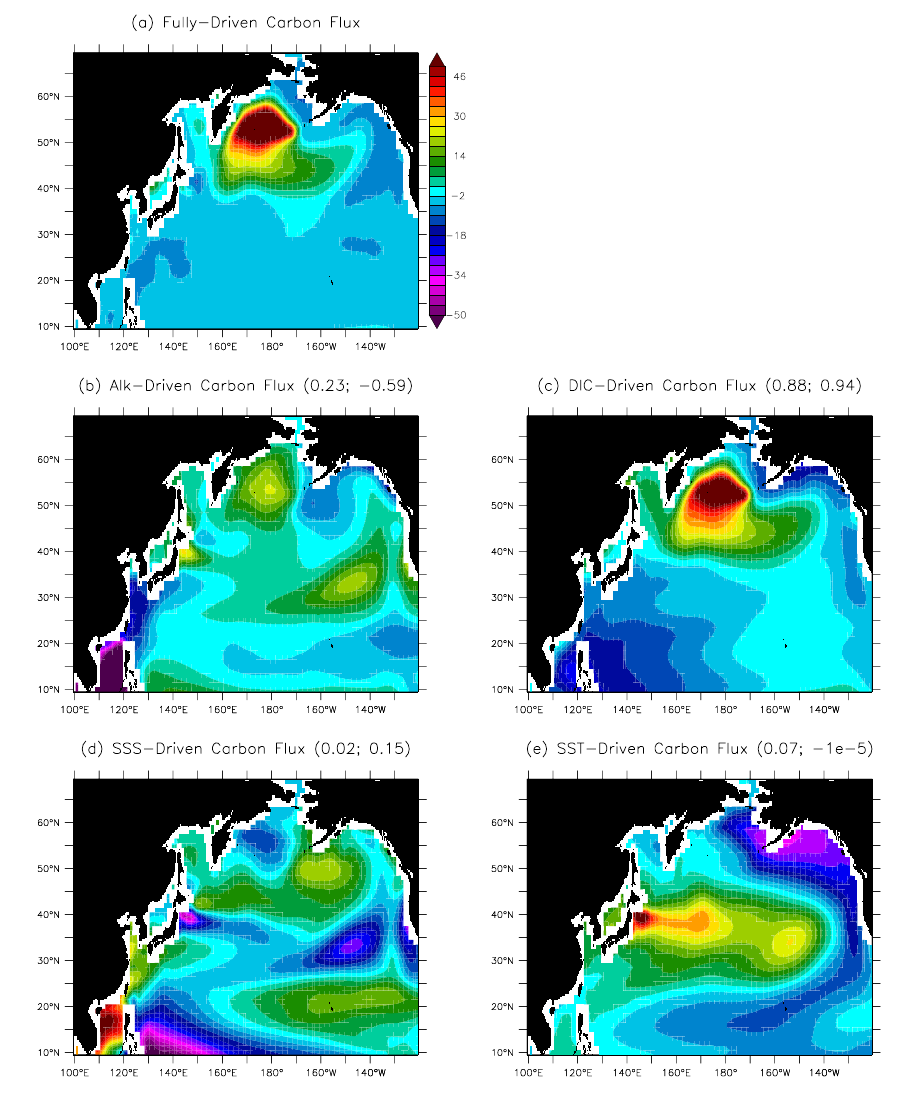
Fig. 6. Spatial pattern of the leading empirical orthogonal function (EOF, in normalised unit) of (a) the fully-driven carbon fluxes, and that of the Alk-driven (b) , DIC-driven (c) , SSS-driven (d) and SST-driven (e) ocean carbon fluxes in the North Pacific. Spatial correlations (based on EOFs) and temporal correlations (based on CPs) between each driver-related and the fully-driven ocean carbon fluxes are mentioned in